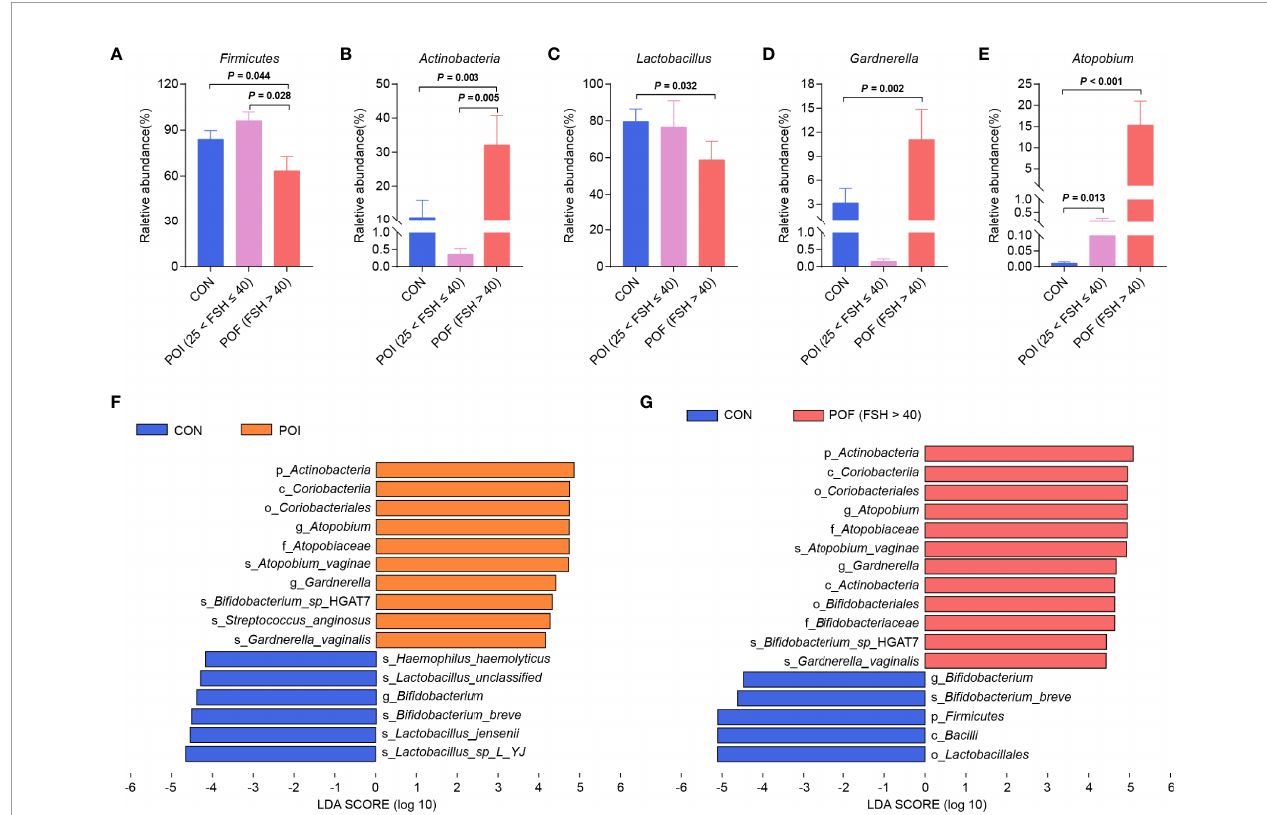
FIGURE 2 | Comparison of vaginal microbiota composition between POI (25 < FSH ≤ 40) and POF (FSH > 40) subgroups. (A – E) Differences in relative abundance of Firmicutes , Actinobacteria , Lactobacillus , Gardnerella , and Atopobium . (F) . Histogram of the LDA scores for differentially abundant bacterial taxa between the control and the POI groups (LDA > 4). (G) . Histogram of the LDA scores for differentially abundant bacterial taxa between the control group and the POF (FSH > 40) subgroup (LDA > 4). LDA, linear discriminant analysis. P < 0.05 was considered statistically signi fi